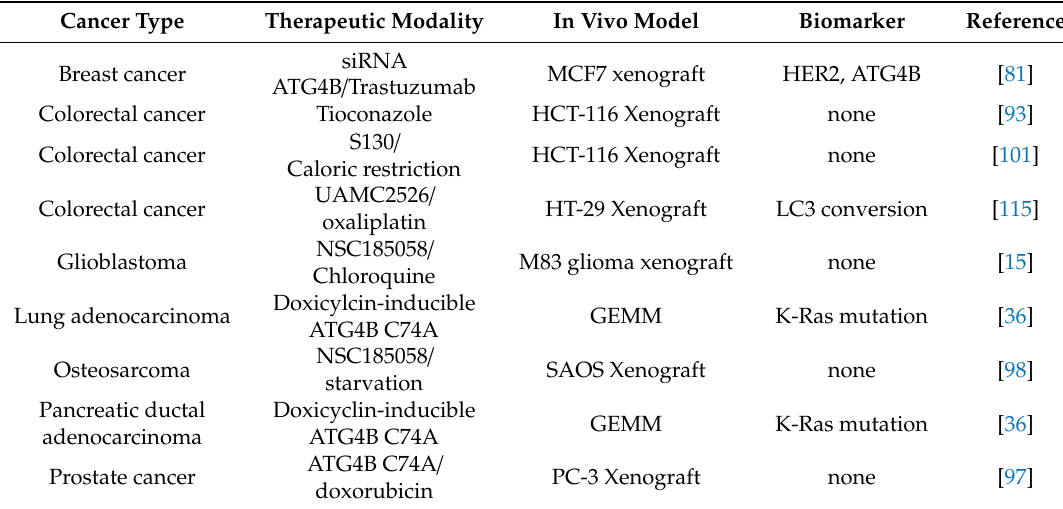
Table 1. In vivo models and potential biomarkers for ATG4B inhibition in cancer.